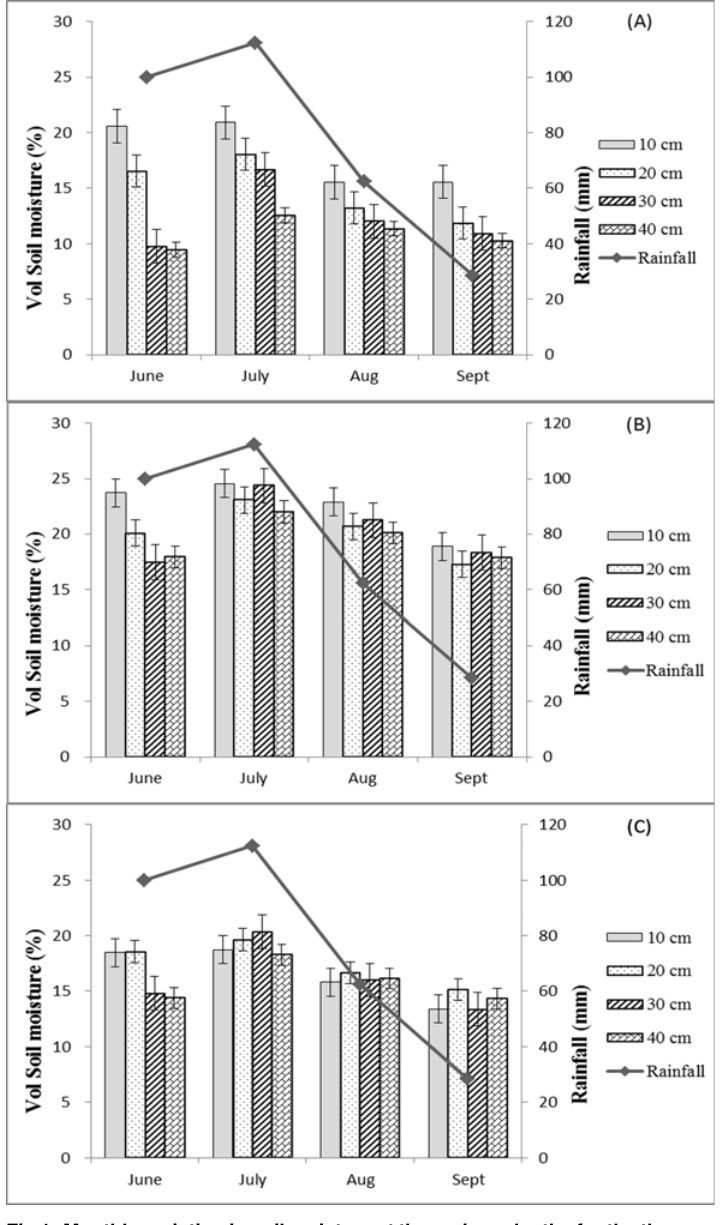
Fig 1. Monthly variation in soil moisture at the various depths for the three vegetation types during the rainy season. (A) Soil-moisture content of AL, (B) soil-moisture content of QM, and (C) soil-moisture content of UG. Notes: AL, artificial Larix spp.; QM, Quercus mongolica ; UG, unused